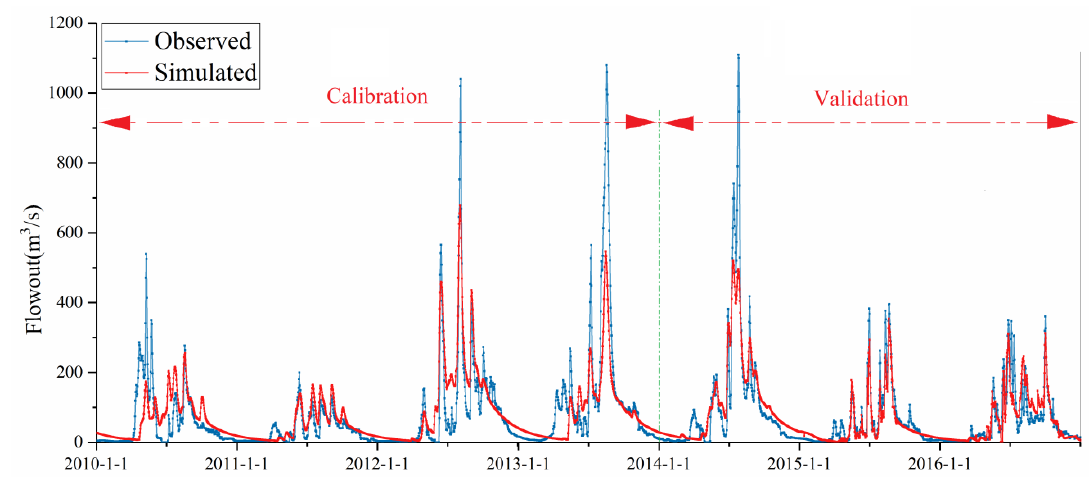
Figure 5. Observed and simulated daily runo ff at Qinjia Station before code Figure5. Observed and simulated daily runoff at Qinjia Station before code modification